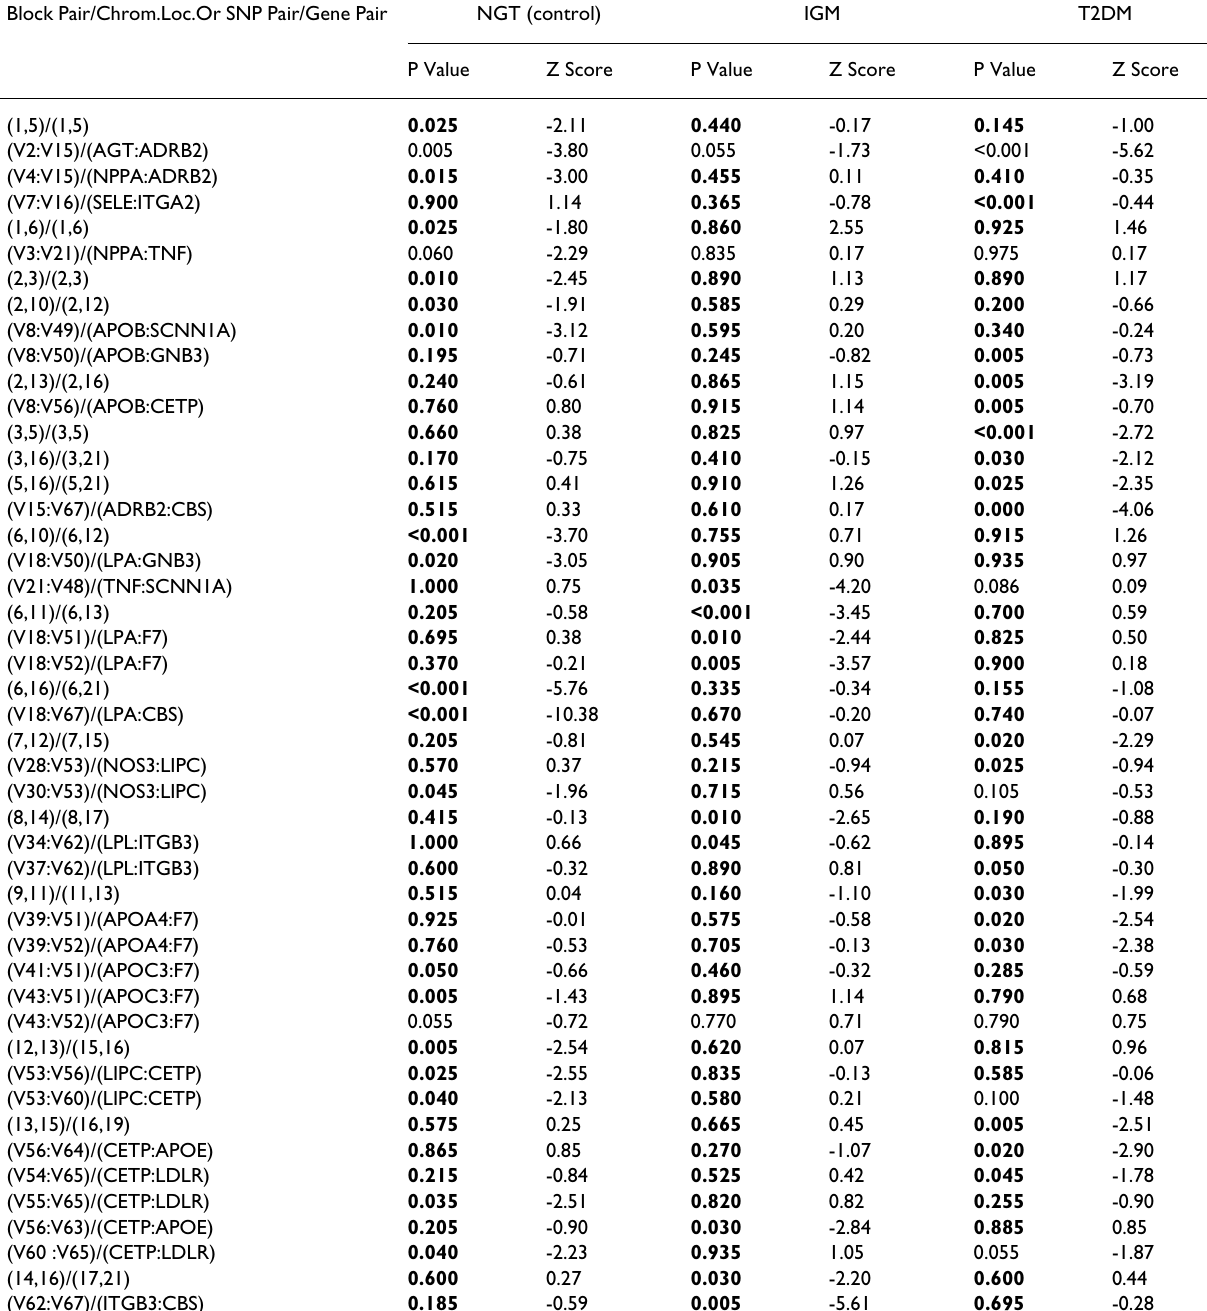
Table 4: Haplotype Interactions between Blocks, i.e. interactions between polymorphisms in genes that are located on different chromosomes. Significant up- or down- interaction is indicated with bold typeface. Block Pair/Chrom.Loc.Or SNP Pair/Gene